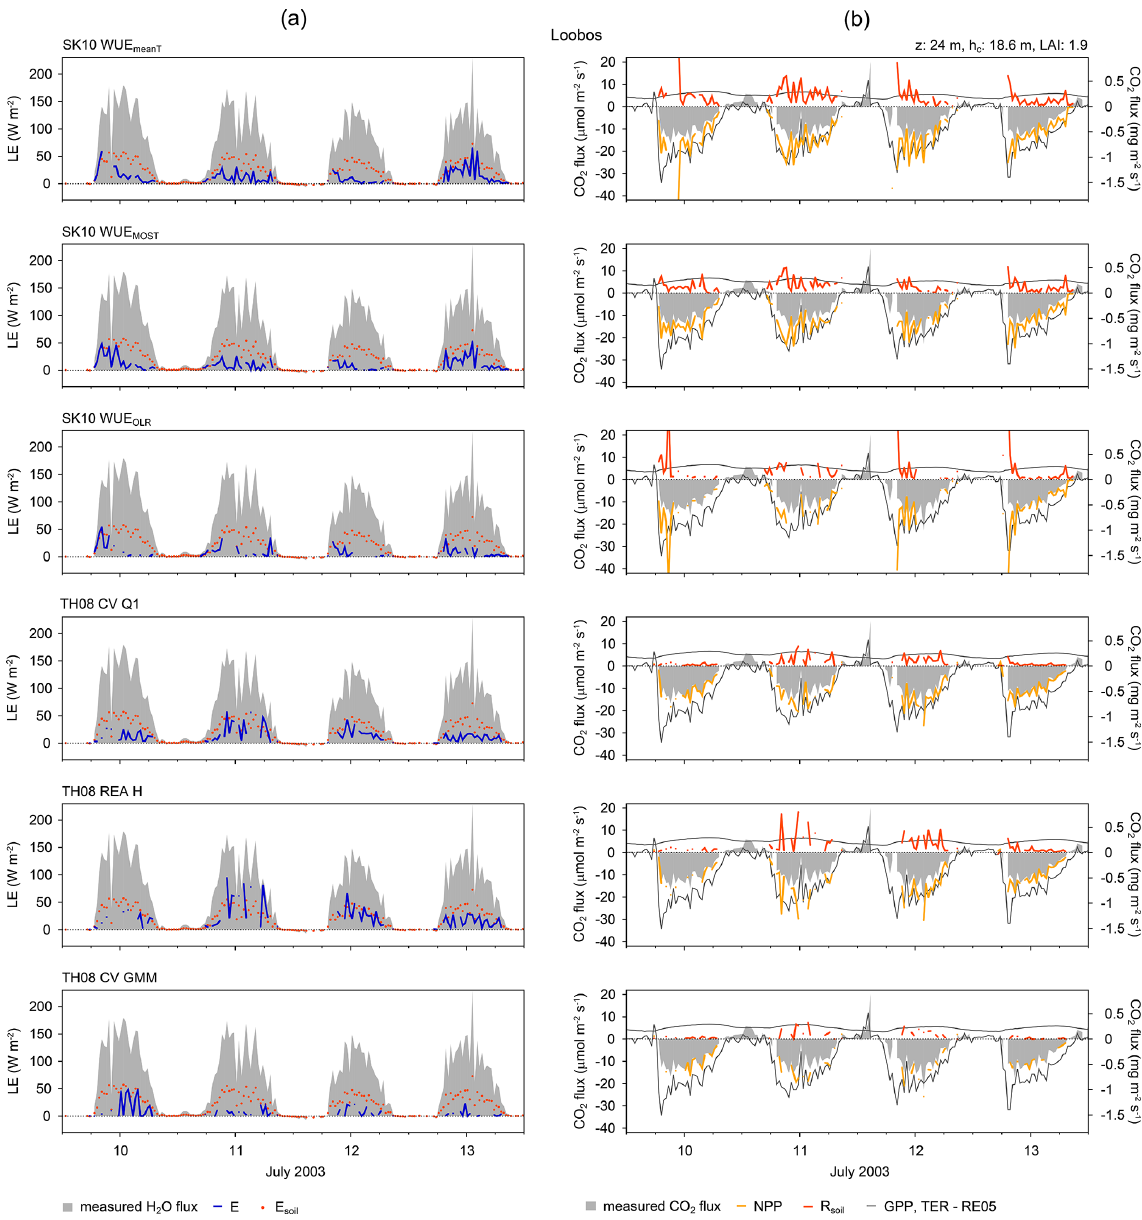
Figure 2. Source partitioning results for (a) H 2 O and (b) CO 2 fluxes in half-hourly time steps for the Loobos study site (forest) in the Netherlands. The figure shows 4 days of the considered time period and selected method versions (see text for description). Results for all days and for every method version are shown in the Supplement. Grey areas show the measured water and CO 2 fluxes. Soil evaporation estimates derived based on Beer’s law and CO 2 flux estimates by Reichstein et al. (2005; RE05) are also included (LE: latent heat